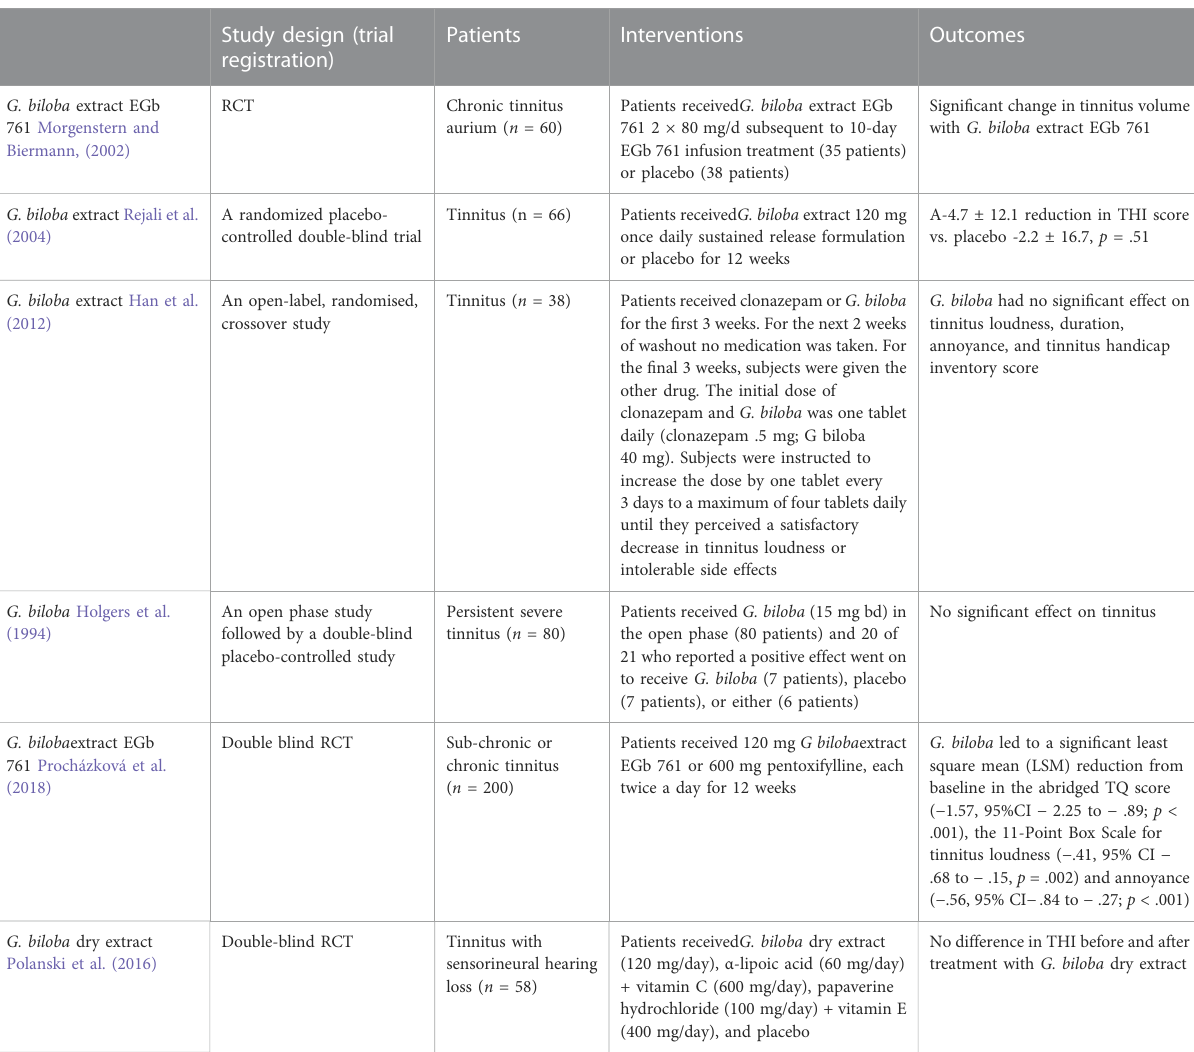
TABLE 1 G. biloba in the treatment of